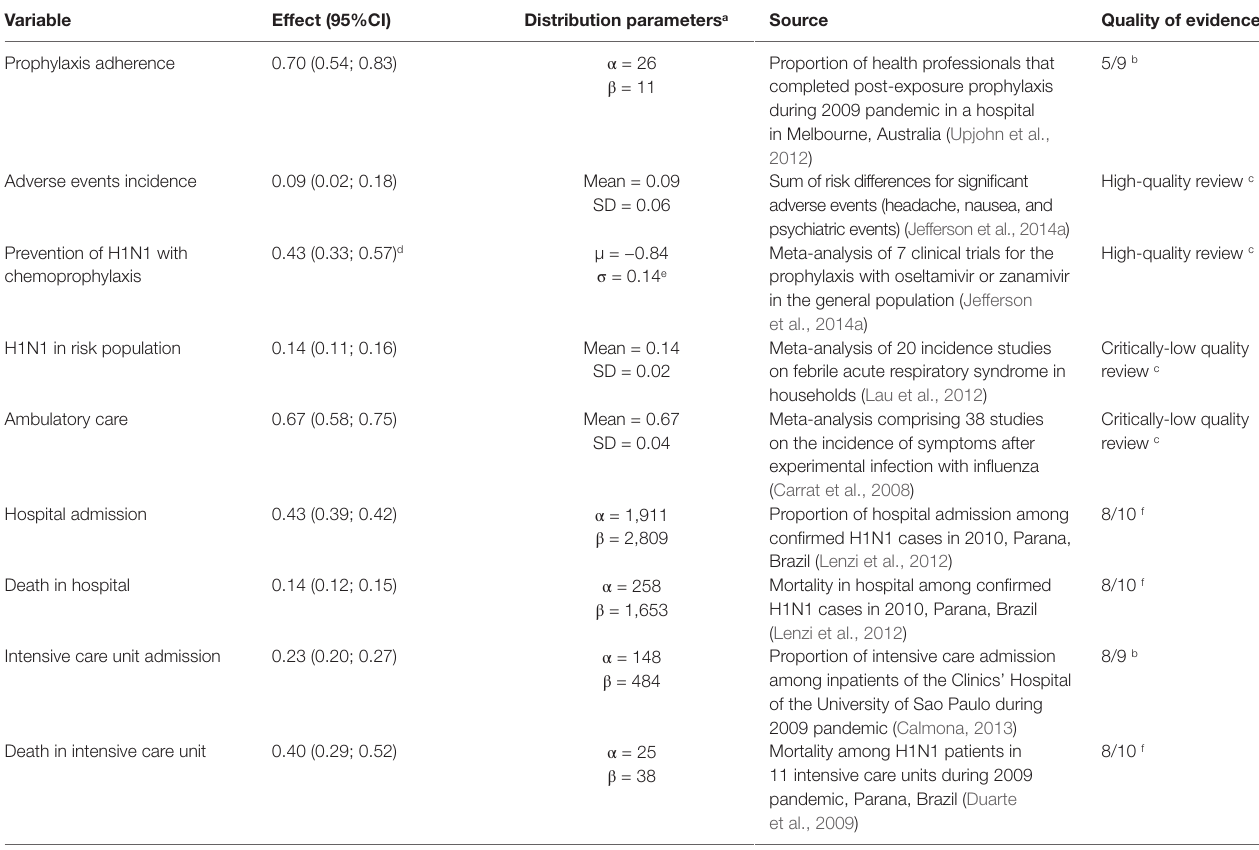
TABLE 1 | Probabilities of outcomes, distribution parameters adopted in the analytical model, and sources.